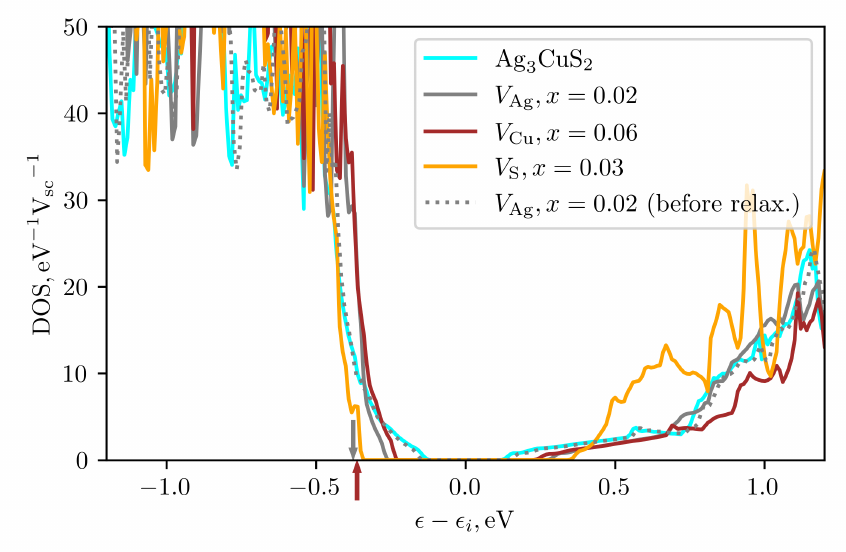
Figure 11. The density of states around the band gap of pure Ag 3 CuS 2 and in the presence of Ag, Cu, and S vacancies with the atomic fraction x . The arrows show the positions of Fermi energy for Ag and Cu vacancies. Gray dotted curve shows DOS in the presence of Ag vacancy before atomic relaxation. Energy is counted from the middle of the band gap (cid:101) i